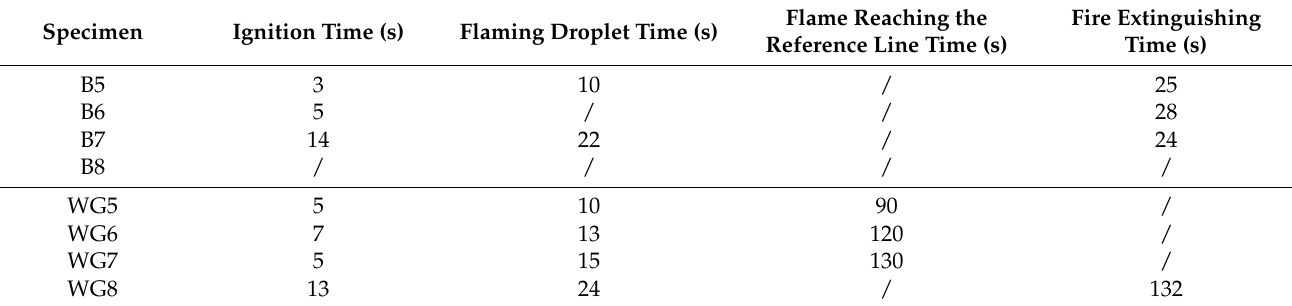
Table 3. Resistance to fire properties for the specimens with a thickness of 50 mm.